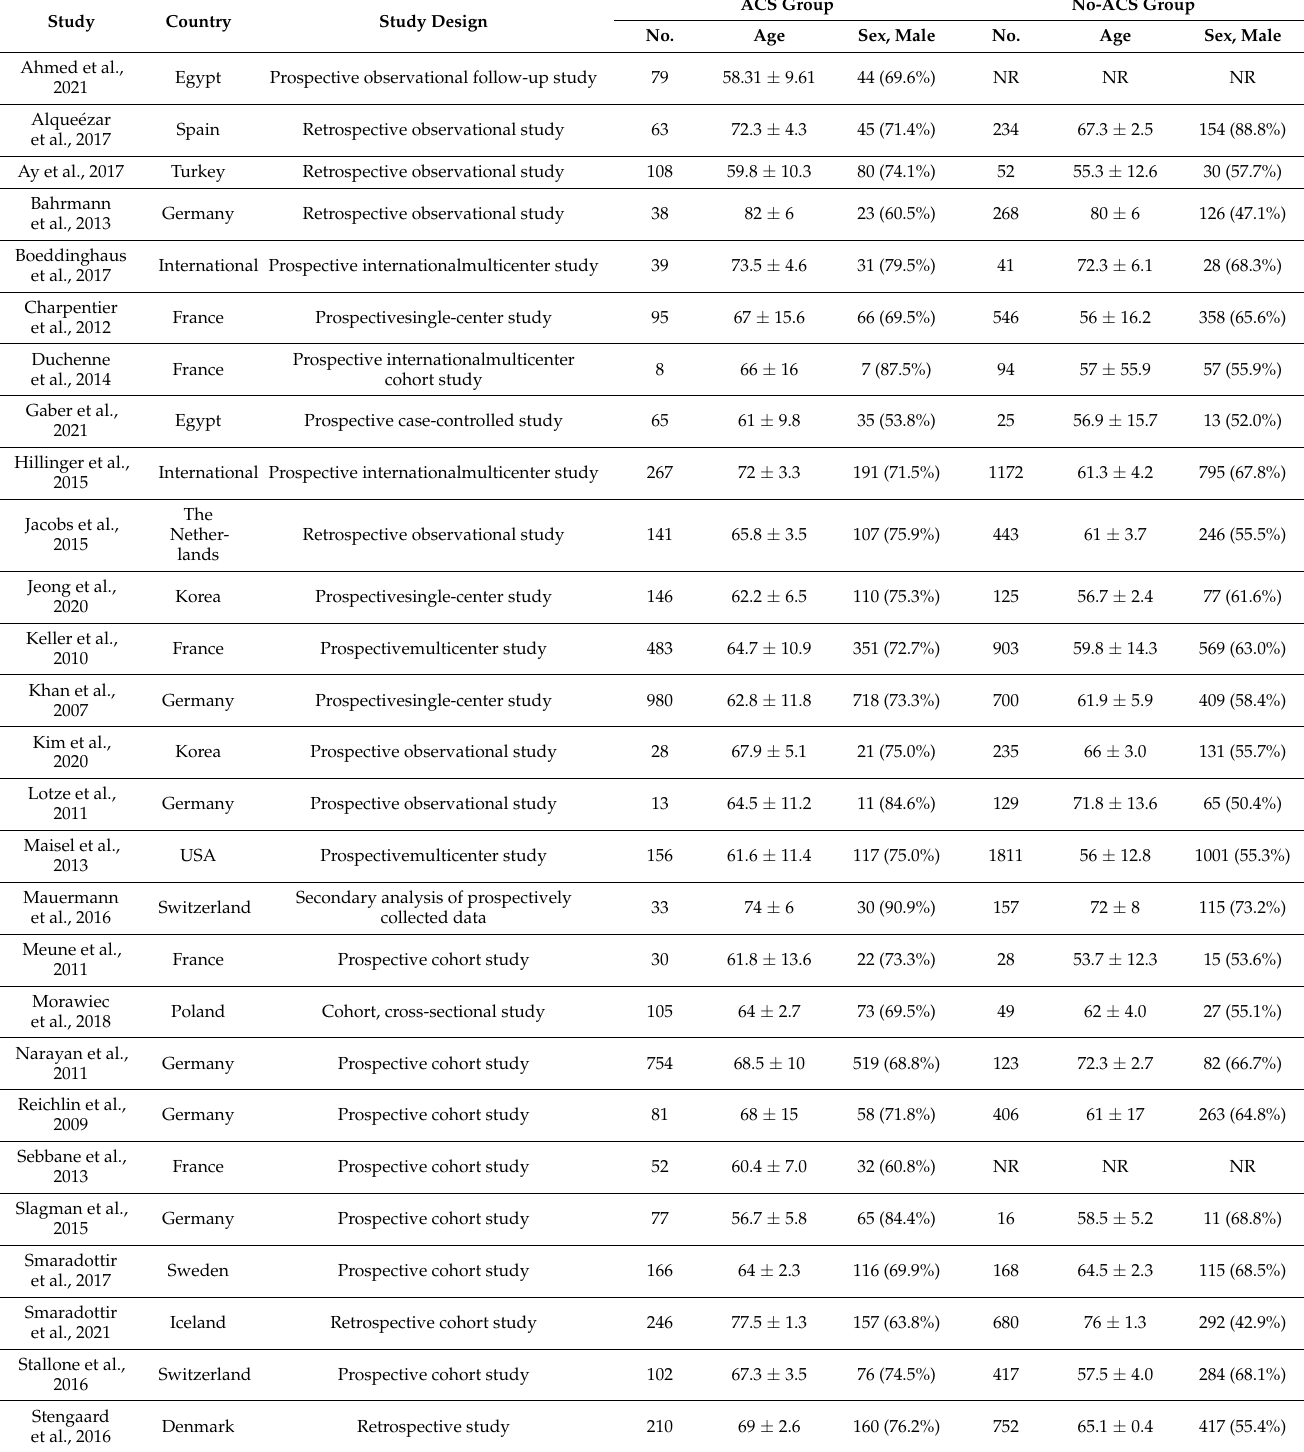
Table 1. Characteristics of included studies. Legend: NR = not